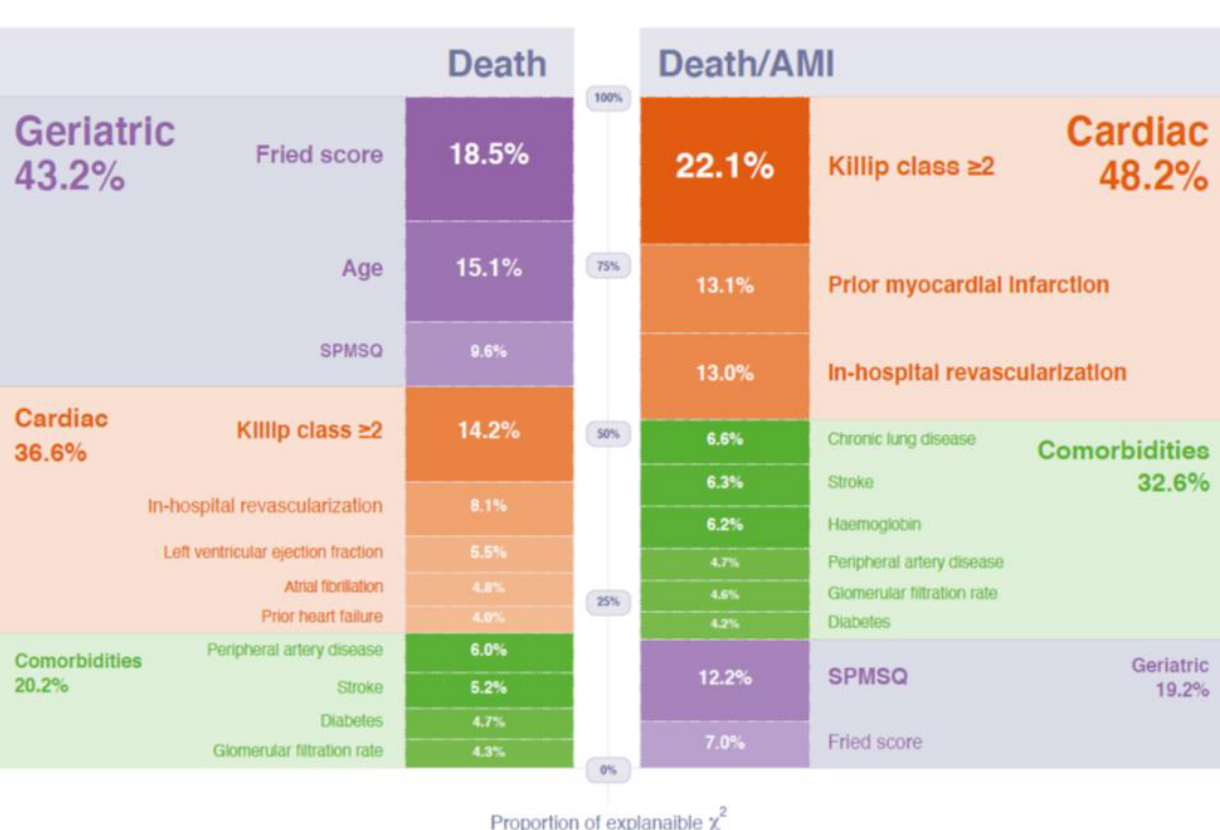
Table 5. Multivariable model for mortality (total number of deaths = 216).